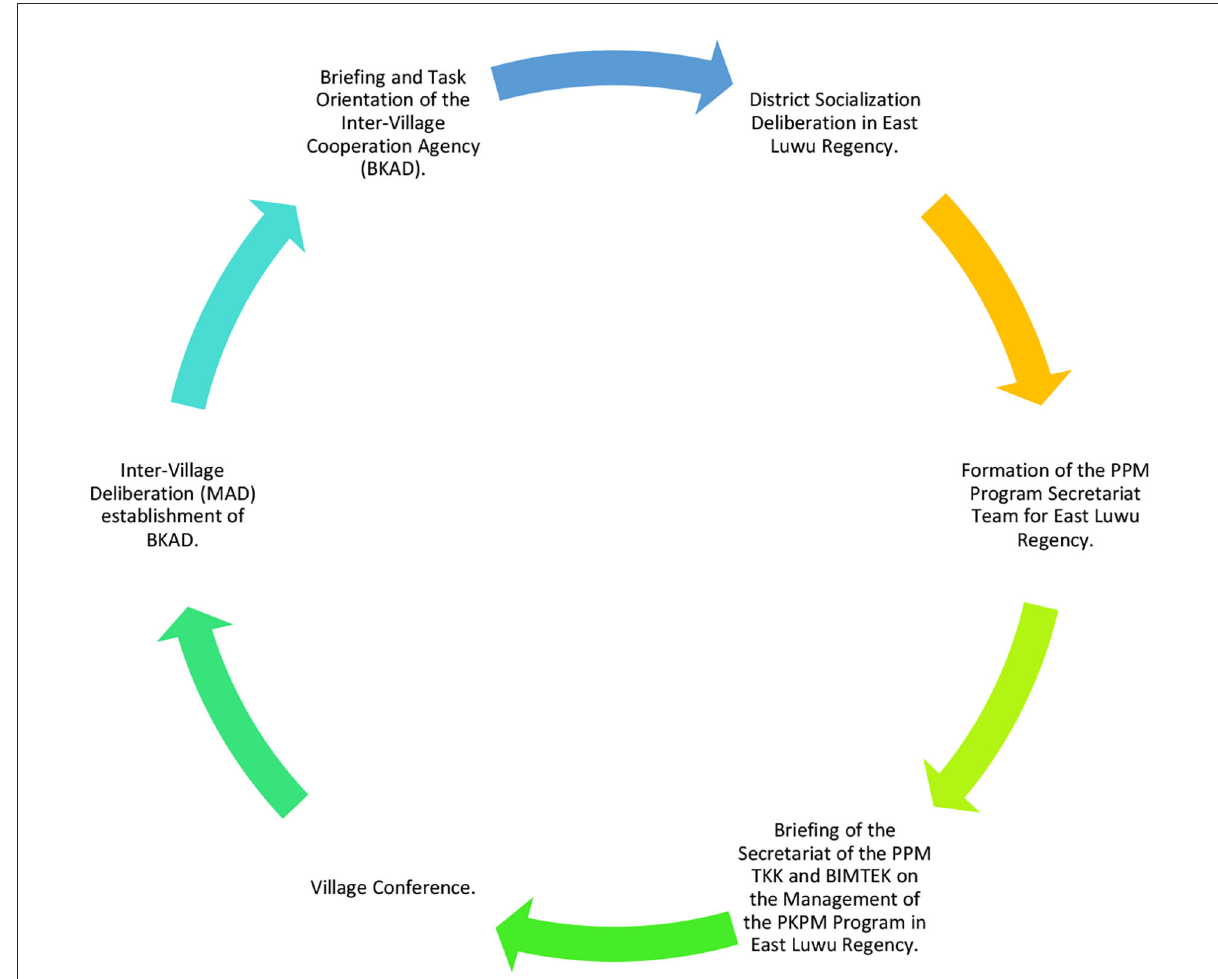
FIGURE3 Stages of the development process of independent Villages in East Luwu Regency. Source: Processed from various sources,